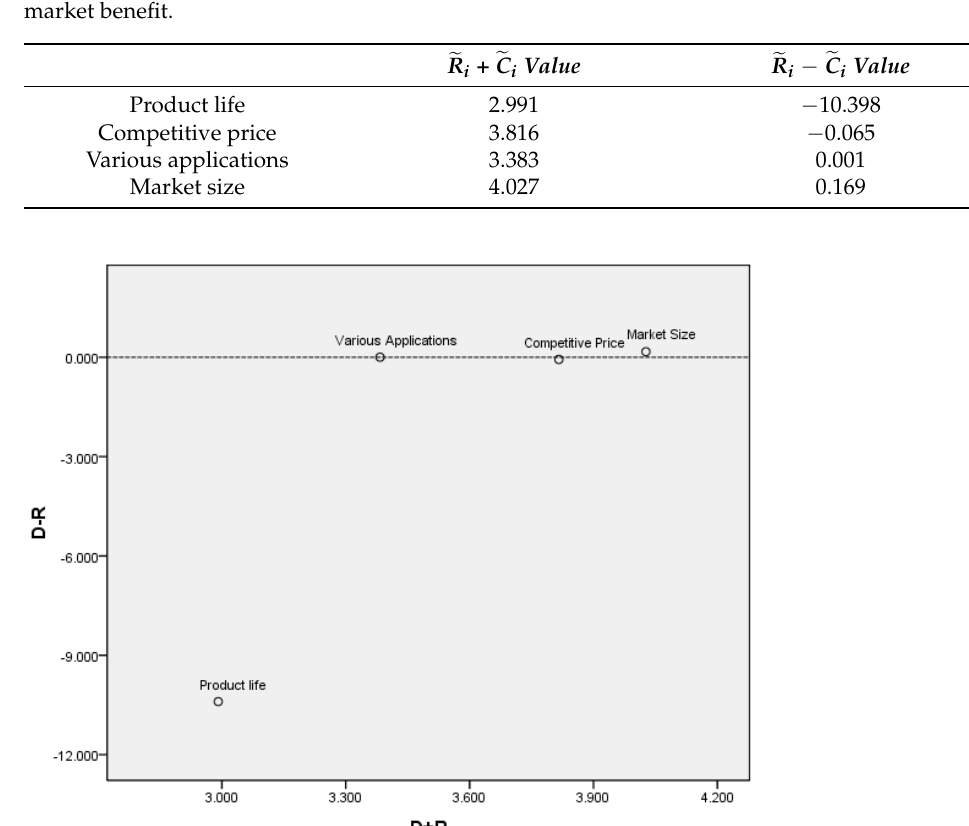
Table 5. The sum of (cid:101) R i value , (cid:101) C i value , (cid:101) R i + (cid:101) C i value and (cid:101) R i − (cid:101) C i value impacts of the second-level criteria of the technological ability.